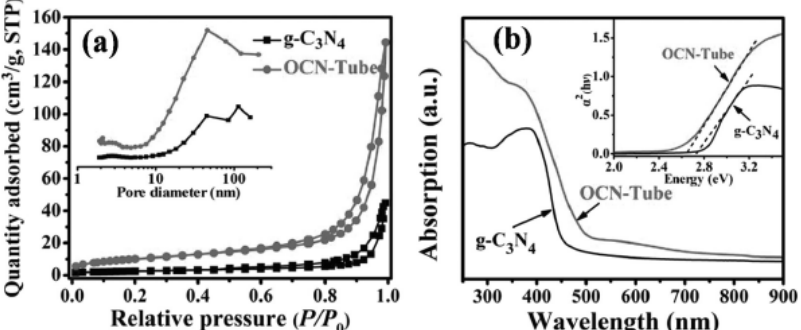
Figure 11. ( a ) N 2 adsorption–desorption isotherms along with corresponding pore size distribution curves and ( b ) ultraviolet–visible (UV–Vis) di ff usion reflectance spectra (DRS) of bulk and OCN-tube, reprinted with permission from [87].